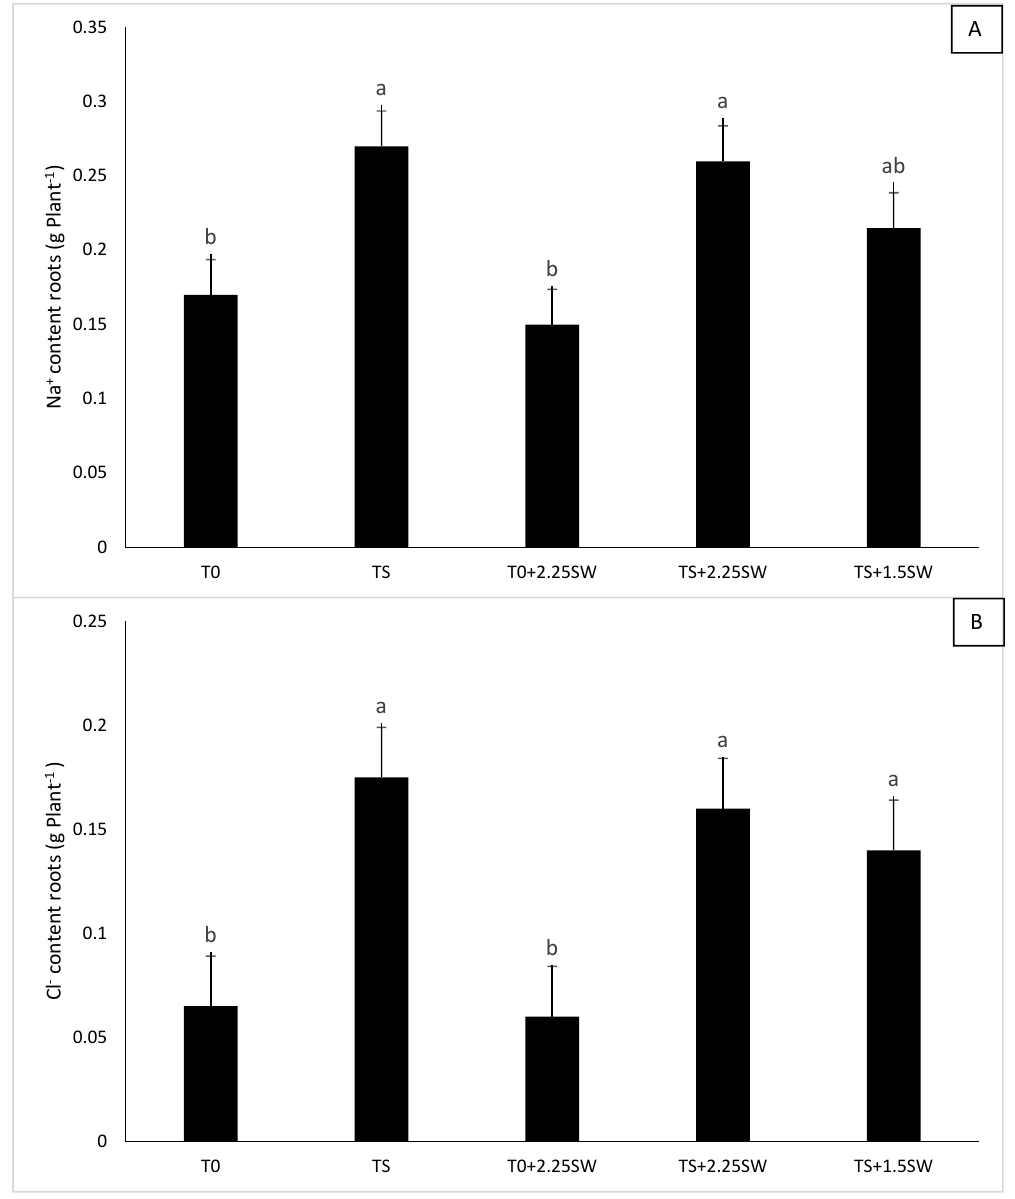
Figure 5. ( A ) Na + and ( B ) Cl − content in roots of 2 year Hass avocado plant grown in pot for 240 days with different treatments (T0: distilled water, TS: saline water (9 mM NaCl), T0 + 2.25SW: distilled water + 2.25 mL seaweed, TS + 2.25SW: saline water (9 mM NaCl) + 2.25 mL seaweed T0 + 1.5 mL seaweed) for 240 days, with 6 replicates per treatment. Means with different letters indicate significant differences between treatments (Tukey test p <